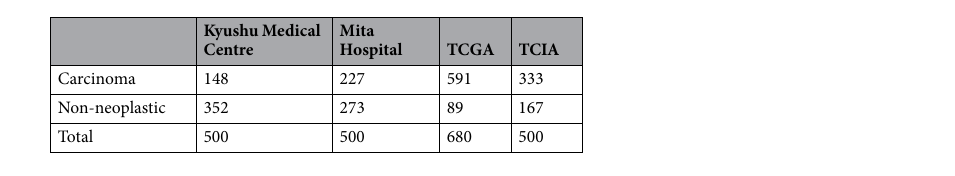
Table 3. Summary of number of WSIs in each test